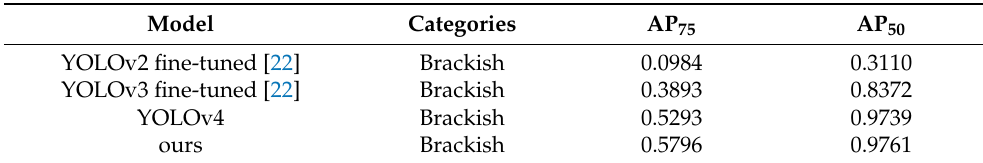
Table 2. Results of the models evaluated on the Brackish categories and compared by AP 75 and AP 50 metrics.